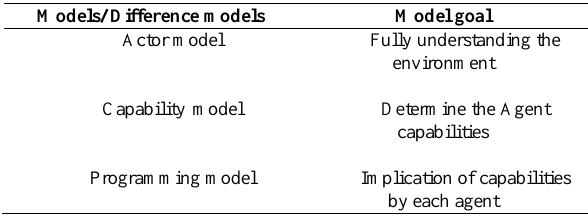
Table 5. Structural analysis of the difference between the ARA methodology and studied